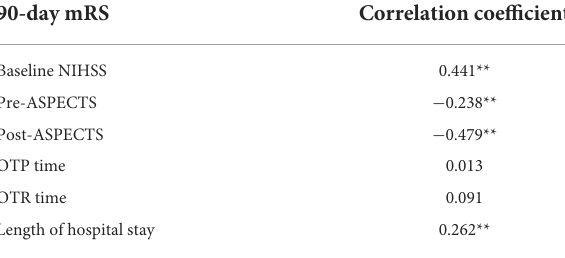
TABLE 2 Correlation analysis of 90-day